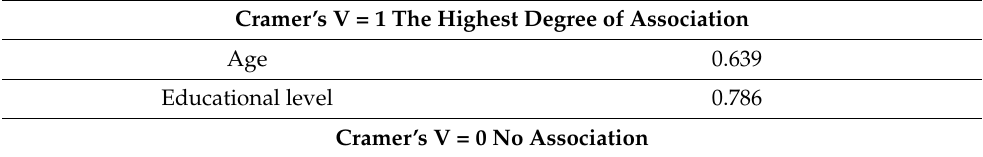
Table 6. Cramer’s V Coefficient results for the social variables under consideration.